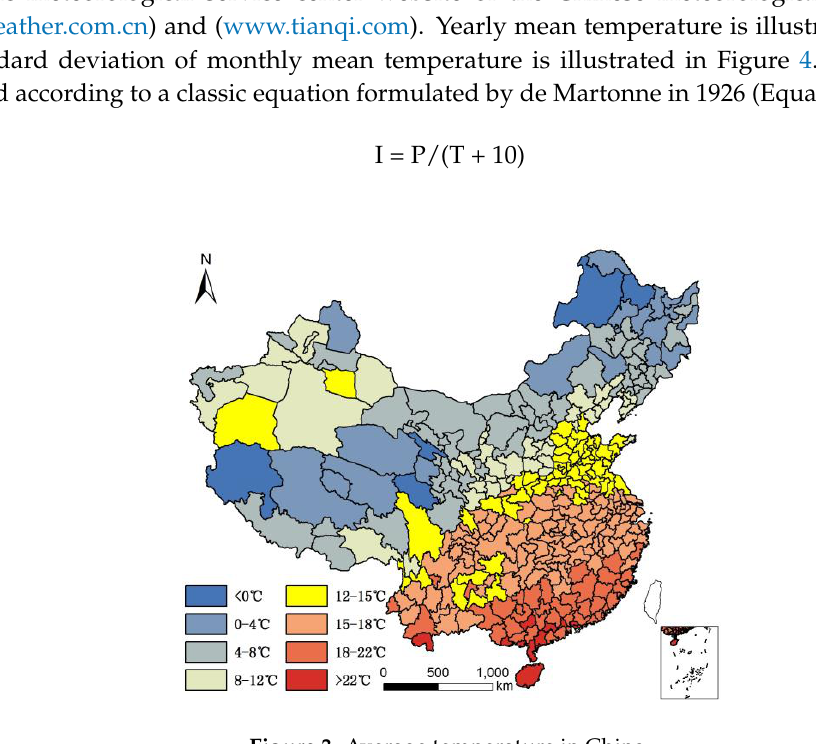
Figure 2. Longevity rate (85+/65+) in China in 2010.